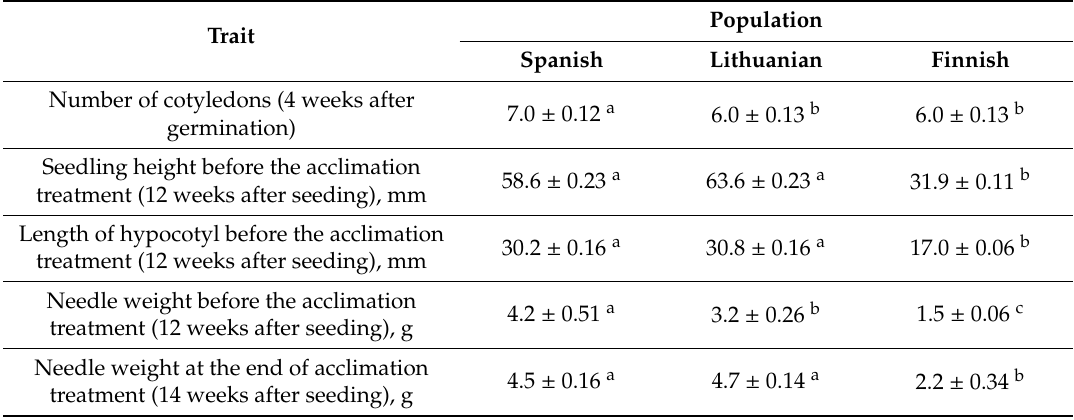
Table 1. Quantitative traits of pine seedlings before and after the cold acclimation treatment. Trait